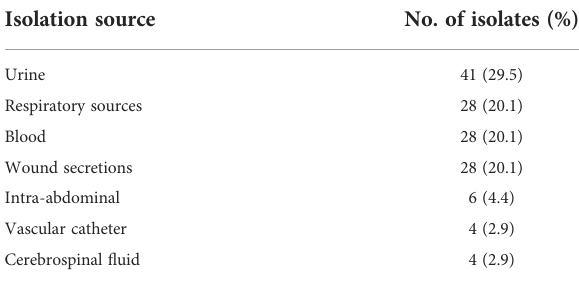
TABLE 3 Sources of Klebsiella pneumoniae NDM-1 isolates. Isolation